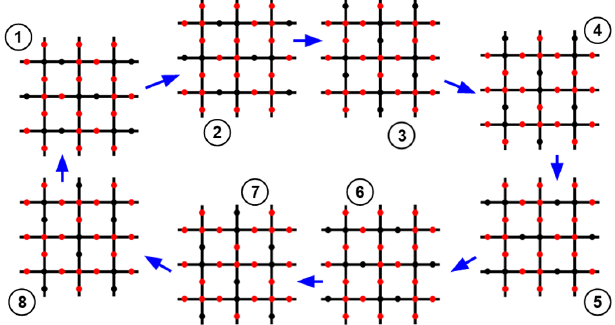
FIG. 1. Measurement protocol. Red vertices indicate the set of repeatedly measured sites, while black sites are unmeasured (the free evolving sets, A ). The adjacent pairs of black vertices trace i out an inherently chiral (in this case clockwise) path along a decorated square inside the Lieb lattice. The path can be made counterclockwise if the order of the eight steps is reversed.